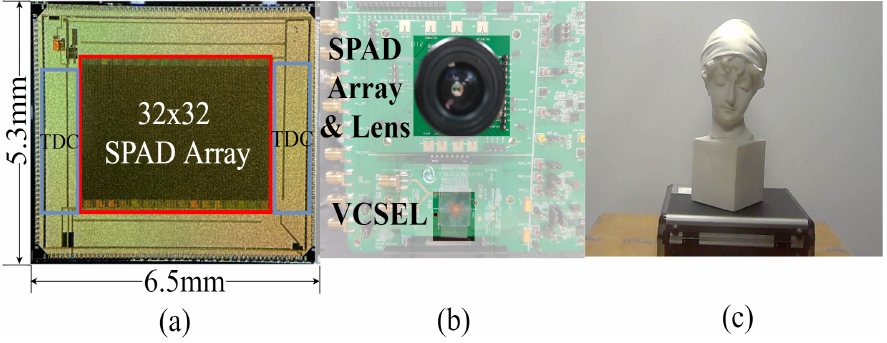
Figure 5. Experimental setup: ( a ) Layout graph of SPAD sensor and placement of vital circuits. ( b ) Evaluation board in this experiment, which was fabricated with on-chip multi-scale histogram circuit design. ( c ) Indoor target